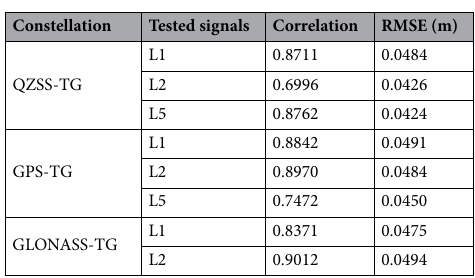
Table 2. Correlation coefficient and root mean square (RMSE) between observed GSI-TG and GNSS (QZSS, GPS and GLONASS) estimated TG.